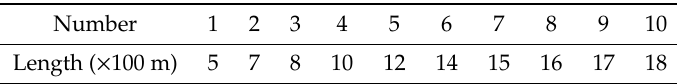
Table 1. Distance Di ff